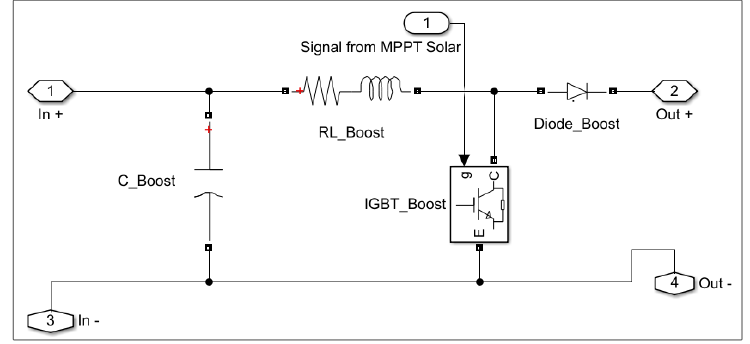
Figure 15. MPPT solar control system.